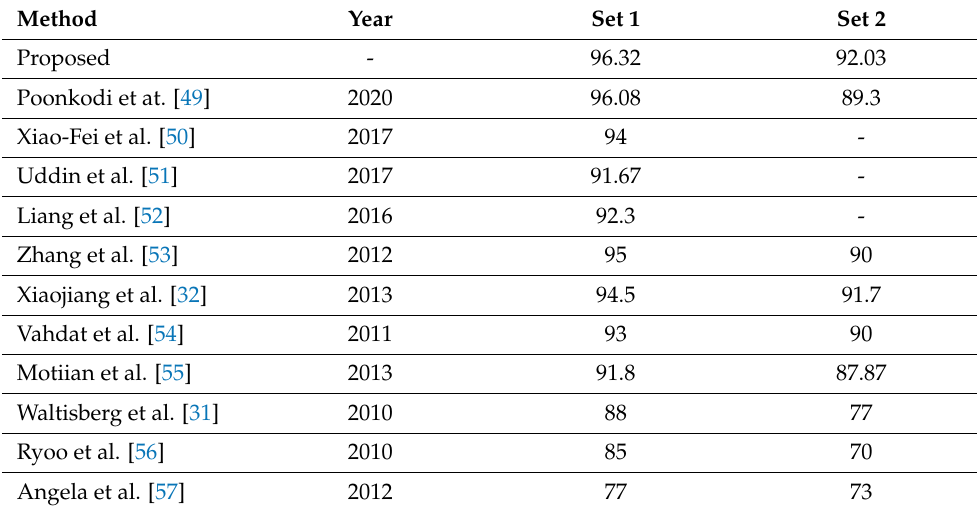
Table 11. State-of-the-art Recognition Accuracy (%) for the UT-Interaction (Set 1 and Set 2) datasets.